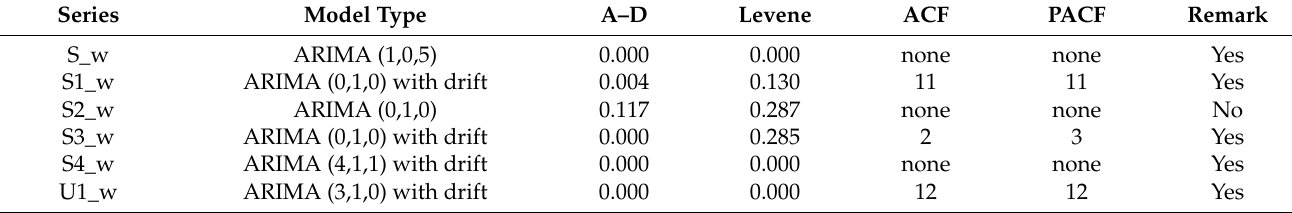
Table 24. Tests of the residuals in ARIMA models for the weekly series S_w, S1_w, S2_w, S3_w, S4_wd, and U1_w.